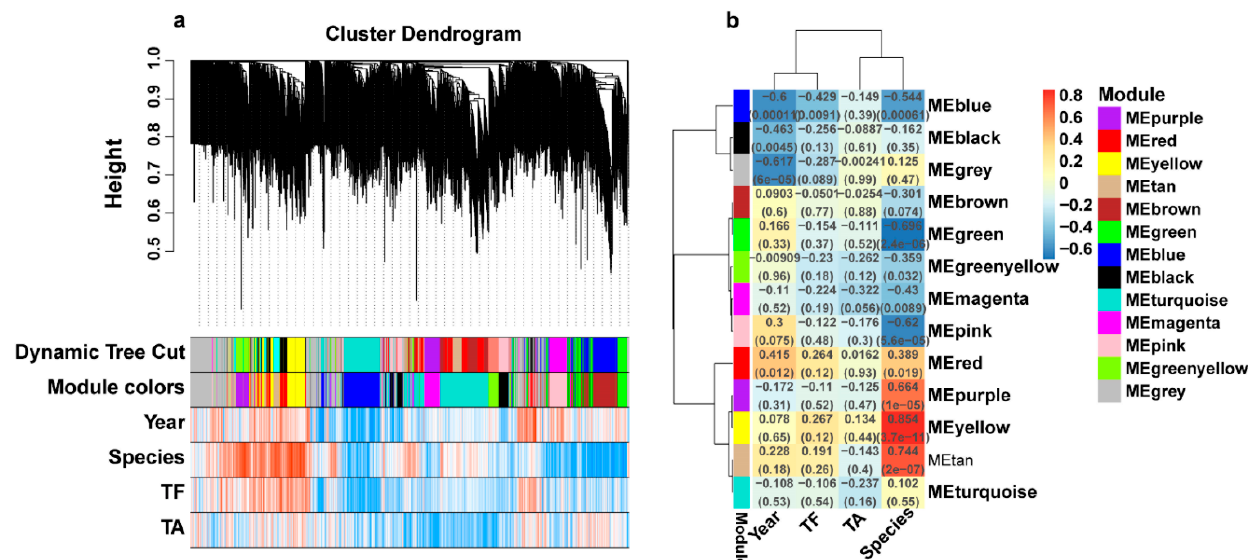
Figure 8. Co-expression network analysis of different growth years and different species. ( a ) Hier- archical clustering analysis tree of DEGs based on topological overlap. ( b ) The module-associated trait. Rows correspond to modules, and columns correspond to features. The number in each cell represents the corresponding correlation and p -value.